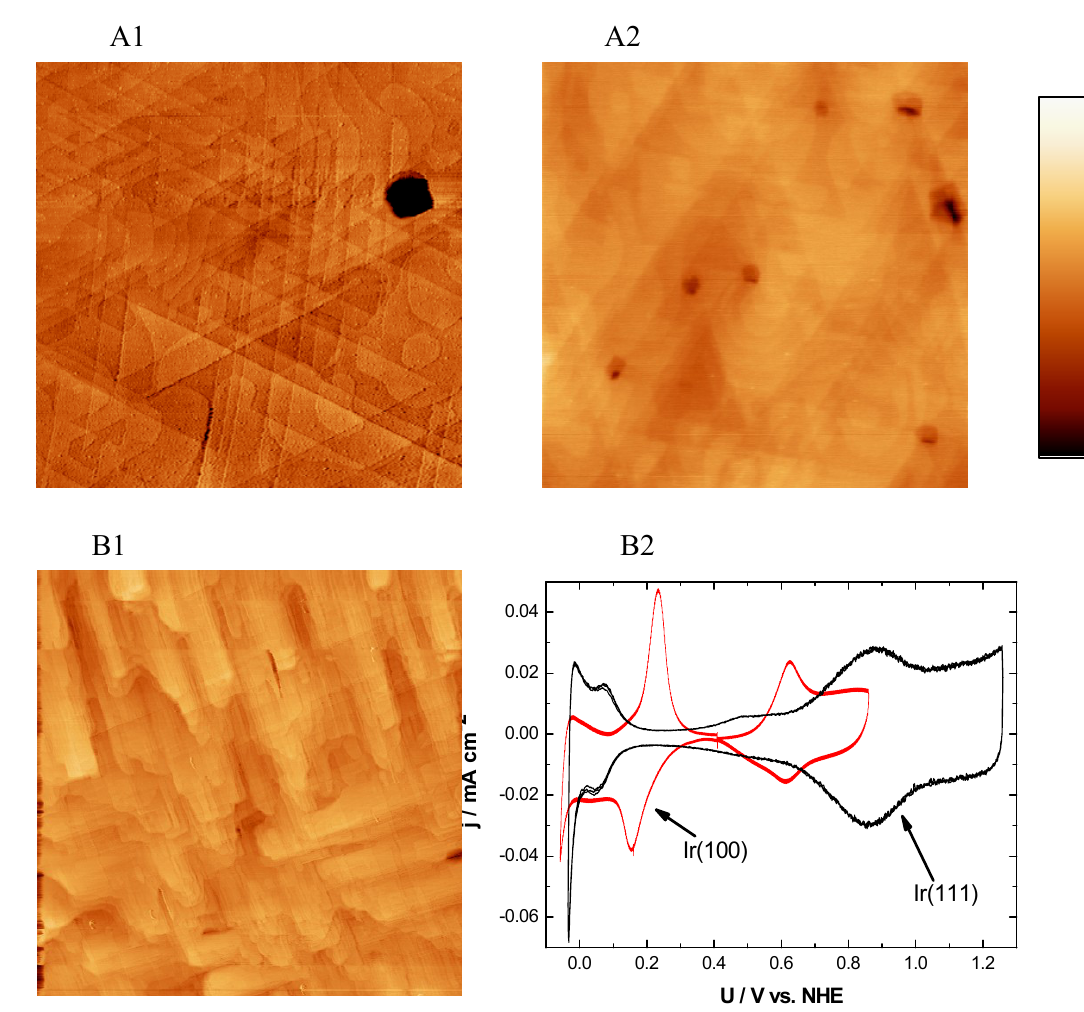
Figure 4. SECPM, AFM and CV of Ir(111) and Ir(100): (A1) SECPM image of Ir(111) = 5.5 nm) in 0.1M HClO at U = 500 mV vs. NHE and (A2) (500 nm × 500 nm, h max 4 S Contact mode AFM image of Ir(111) obtained in air (1000 nm × 1000 nm, h = 5 nm) max image of Ir(111) (B1) STM image of Ir(100) in air (500 nm × 500 nm, h = nm) and (B2) max and 0.01 M HClO4 obtained with a scan rate of CVs of Ir(111) and Ir(100) in 1 M HClO 4 100 mVs -1 and 50 mVs -1 . Imaging conditions: STM: I = 1 nA, U = 100 mV, SECPM: T bias ∆ U = 5